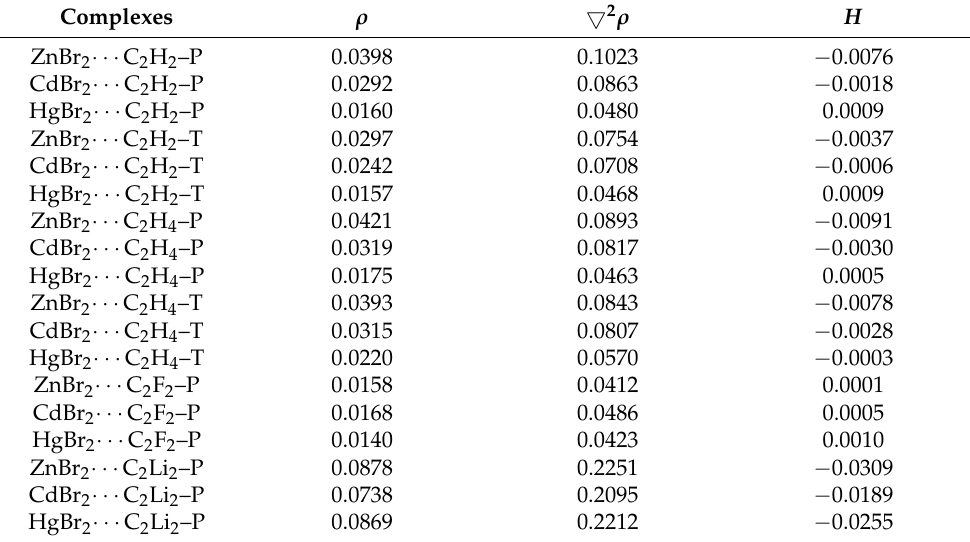
Table 3. Electron density ( ρ in au), Laplacian ( (cid:53) 2 ρ in au), and total energy density ( H in au) at the intermolecular bond critical points (BCPs) in the complexes. Complexes ρ (cid:53) 2